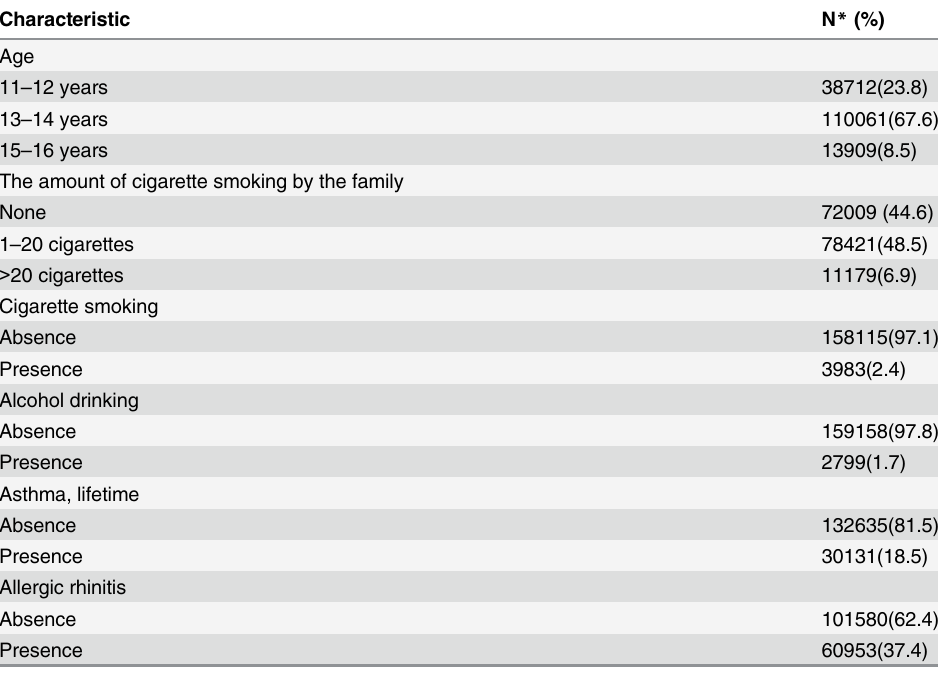
Table 1. Baseline sample characteristics (N =